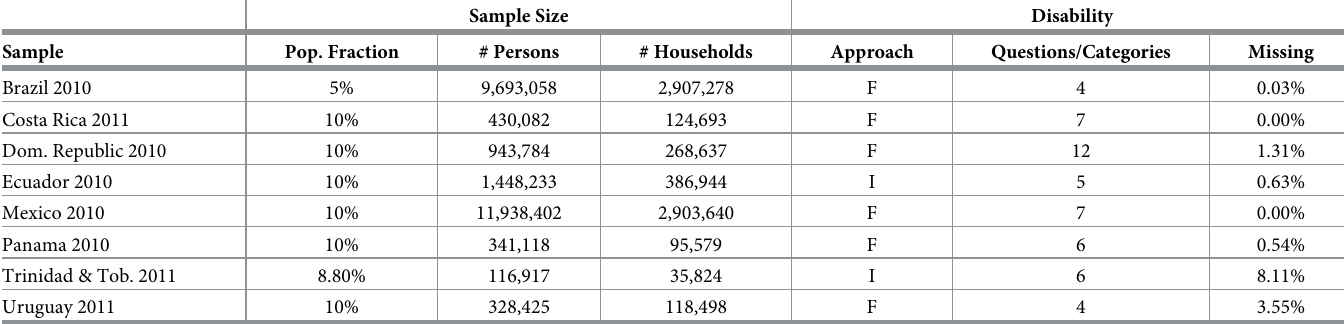
Table 1. Sample size and